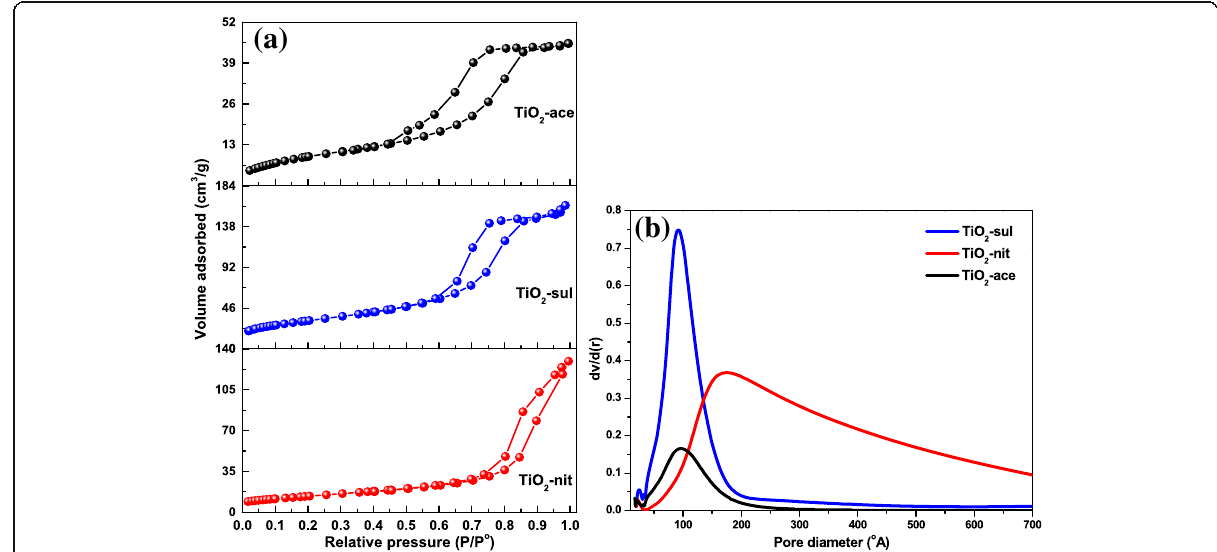
Fig. 5 a N 2 adsorption-desorption isotherms. b Pore size distribution for the calcined TiO 2 samples (reprinted with permission from [29]. Copy- right @ 2017